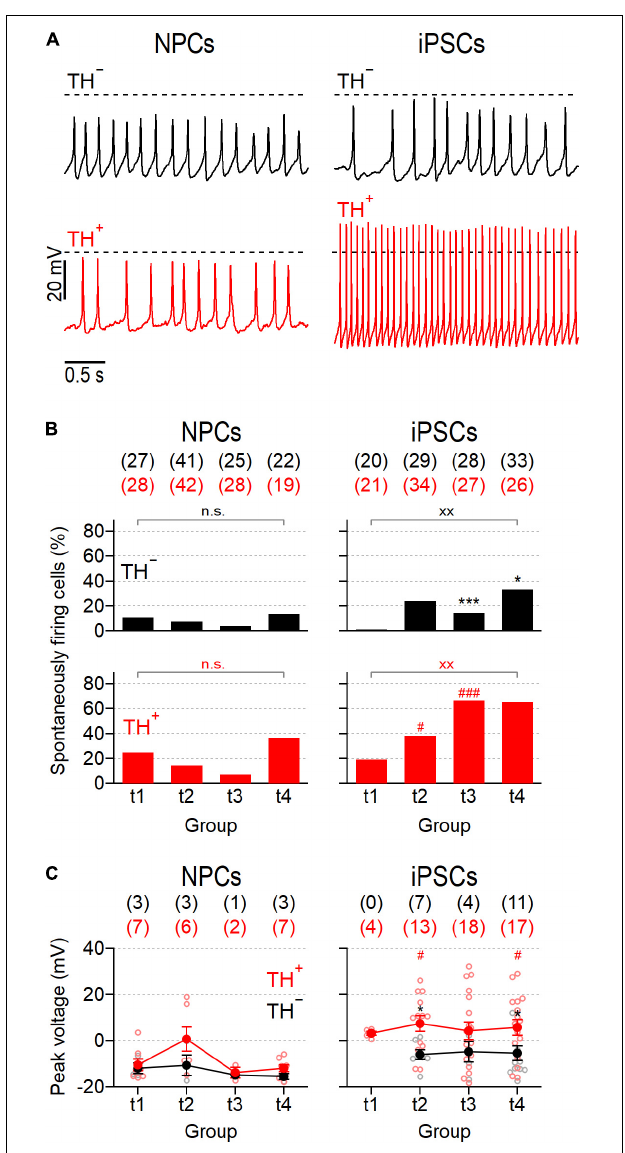
FIGURE 5 | NPC- and iPSC-derived dopaminergic cultures contain different proportions of spontaneously firing neurons. (A) Representative action potential recordings obtained at time point 2 (t2) from NPC- ( left ) and iPSC-derived ( right ) neurons that were negative (TH − , top ) or positive (TH + , bottom ) for the expression of TH, in response to zero current injection. Dashed lines indicate a membrane potential of 0 mV. (B) Percentage of NPC- and iPSC-derived TH − ( top ) and TH + ( bottom ) neurons that fired spontaneous action potentials as shown in (A) , analyzed at different time points during maturation. For each condition, the total number of cells analyzed, n , is provided in parentheses. (C) Average peak voltages (filled circles) of spontaneously fired action potentials as shown in (A) , analyzed at specified time points. Data points are means ± s.e.m. with the numbers of cells analyzed, n , given in parentheses. Straight lines connect data for clarity. Open circles represent data obtained from individual cells. Statistical indicators in (B,C) refer to a Fisher’s exact test and a Mann–Whitney U -test, respectively: *** P < 0.001, * P < 0.05 for testing TH − against TH + neurons of the same line; xx P < 0.01 for comparing data obtained at t1 with data obtained at t4; ### P < 0.001, # P < 0.05 for testing data obtained from NPC-derived neurons against data obtained from iPSC-derived neurons; n.s. not